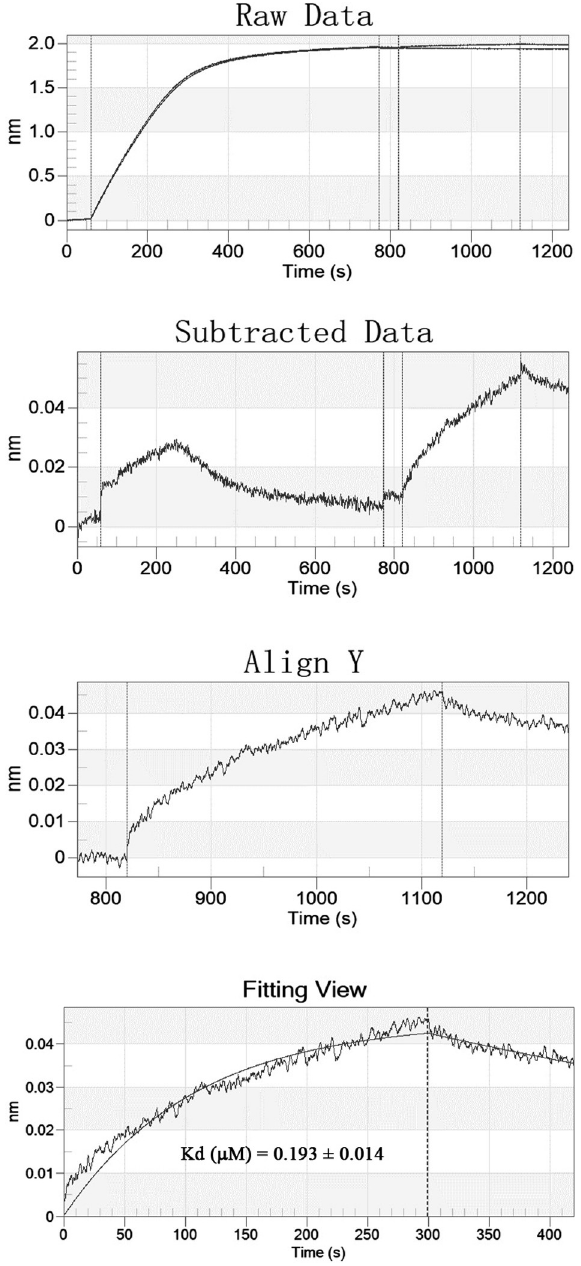
Fig 10. BLI curves (from the raw data to the final fitting view) for the binding of rWLP to biosensors coated with actin. combined with LC-MS/MS analyses (Table 1), providing a set of candidate proteins that interact with WLP. The main localization and function of these pulled-down proteins was the cytoskele- ton (transgelin and actin), biomineralization (shell mytilin-1, PDZ domain-containing protein, and SD-rich protein), and others (collagen and protease inhibitor-like protein) (Table 1). Most of the pulled-down proteins had been identified in the shell proteome of M . coruscus [8], such as shell mytilin-1, a Mytilus -specific shell protein [8, 44], indicating a possible protein network